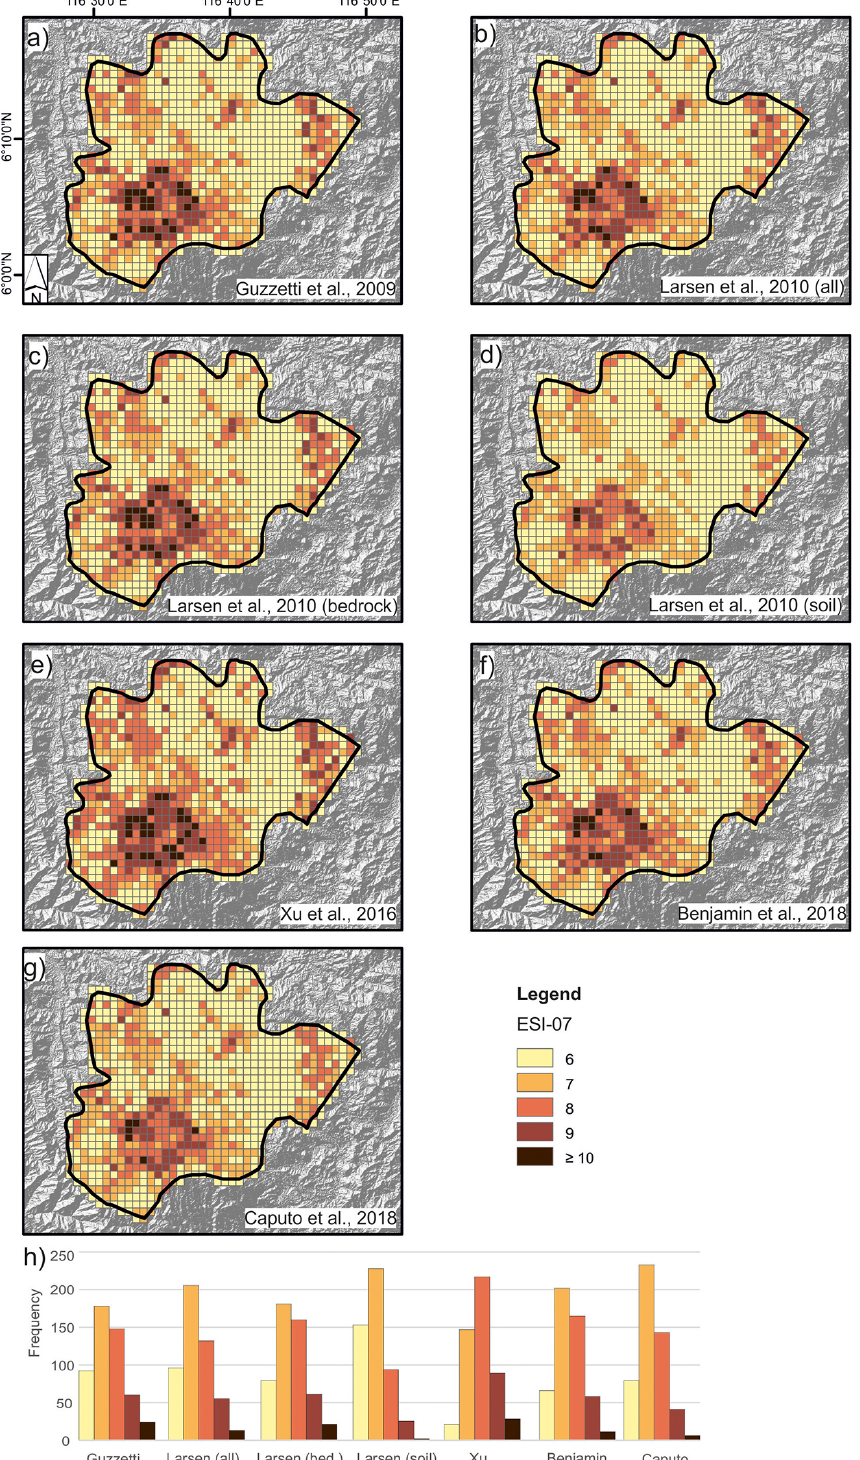
Figure 5. Grid maps of ESI-07 local intensity obtained by adopting different area–volume scaling relations ( a : Guzzetti et al., 2009; b : Larsen et al., 2010, all types; c : Larsen et al., 2010, bedrock; d : Larsen et al., 2010, soil; e : Xu et al., 2016; f : Benjamin et al., 2018; g : Caputo et al., 2018); (h) frequency of cells belonging to the different ESI-07 classes for each scaling